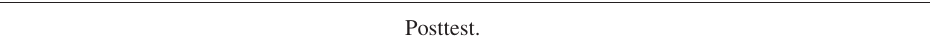
TABLE V. The posttest designed by the teachers. Posttest.